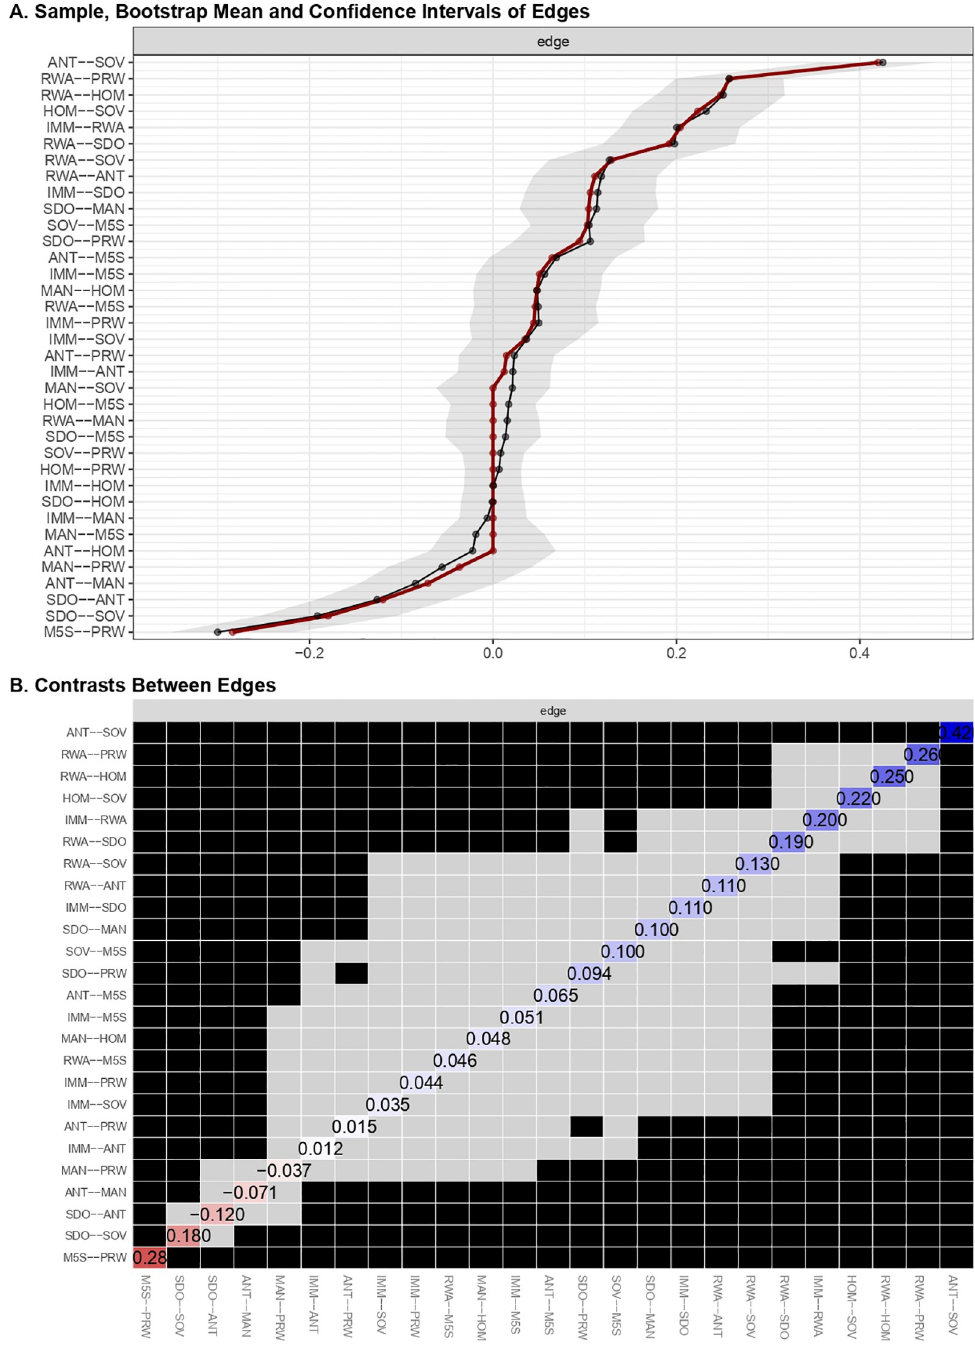
Fig 9. Edge weights of the integrated beliefs system network. (A) Sample, bootstrap means and confidence intervals of edge weights resulting from the integrated beliefs system network. (B) Bootstrap differences of edges weights resulting from the integrated beliefs system